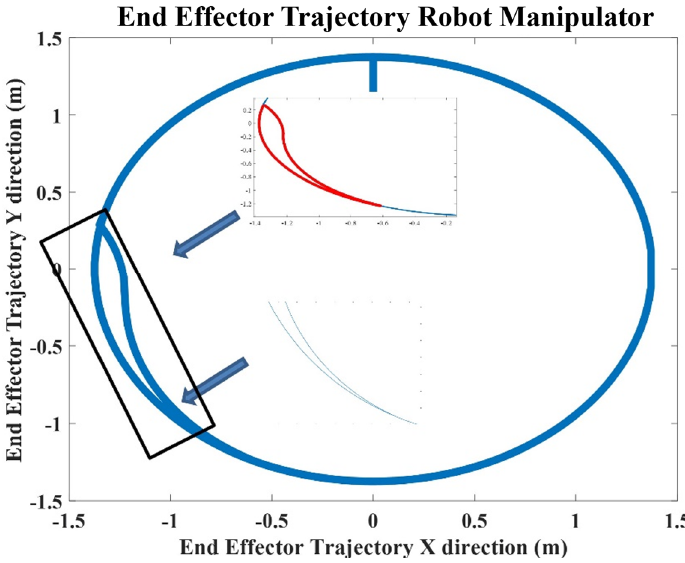
Figure 21. Continuous obstacle avoidance trajectory (end-effector).